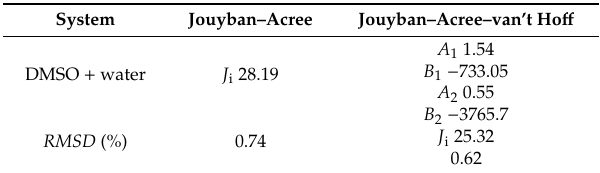
Table 7. The parameters of Jouyban–Acree and Jouyban–Acree–van’t Ho ff models for PPD in binary DMSO + water